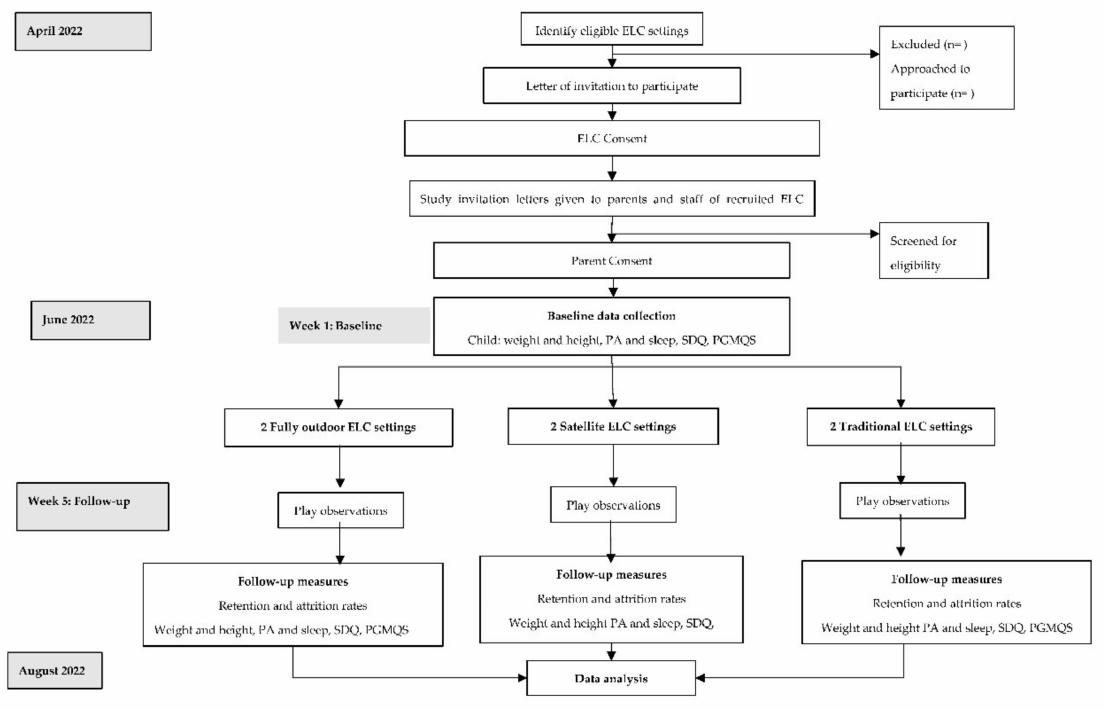
Figure 1. Study flow diagram. ELC—early learning and childcare; PA—physical activity; SDQ— strengths and difficulties questionnaire; PGMQS—preschool gross motor quality